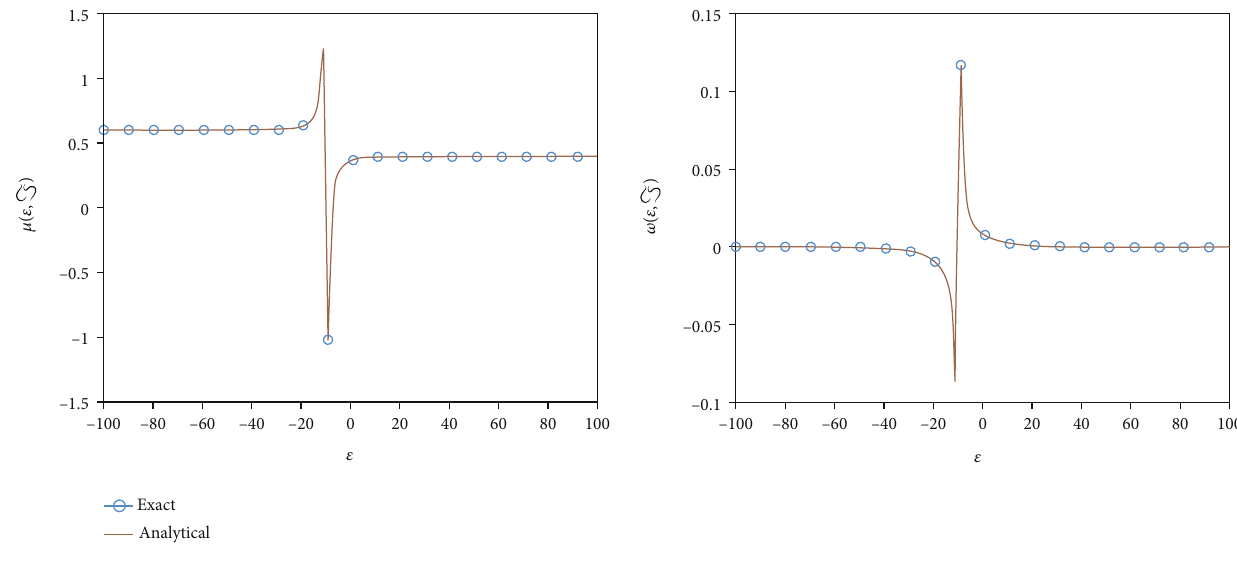
Figure 1: Exact and approximate solution of μ ð ε , I Þ and ω ð ε , I Þ at ϑ = 1 :